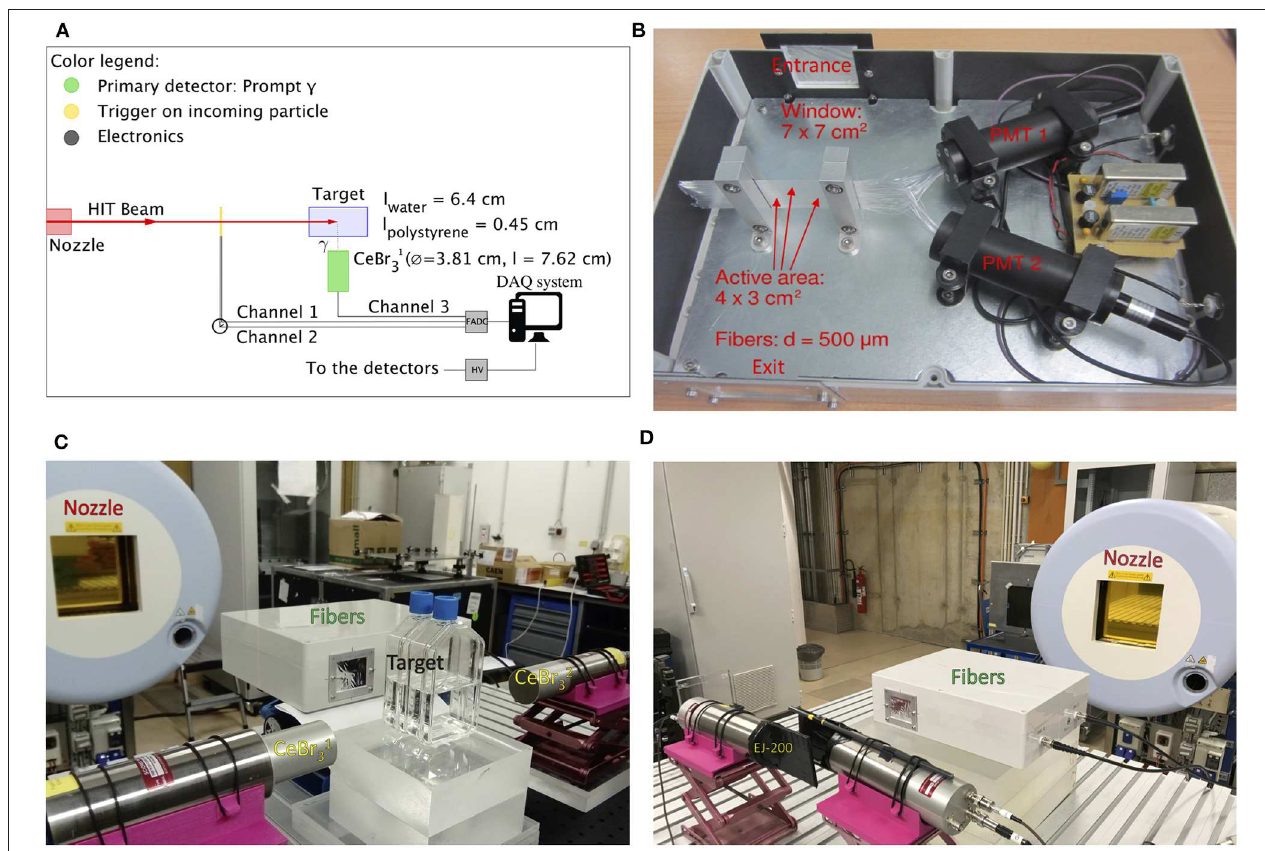
FIGURE 1 | (A) Schematic drawing of the first experimental setup comprising the PGS system and an external trigger detector between the nozzle and the target. (B) Photo of the prototype of a trigger system comprising scintillating fibers connected on one side to two independent PMTs in an alternating fashion. (C) Photo of the first experimental setup. (D) Photo of the second experimental setup with the scintillating fibers and the EJ-200 scintillating tiles placed, in sequence, along the beam axis.